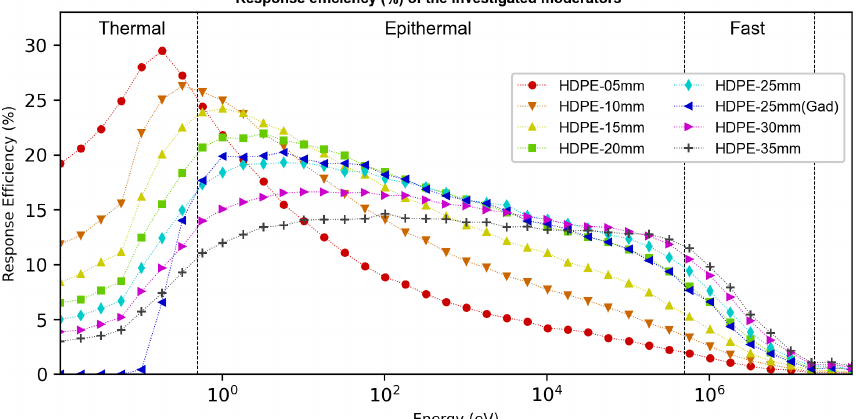
Figure 2. Energy-dependent response functions of different moderators made of 5 to 35mm thick high-density polyethylene (HDPE) and, in the case of 25mm HDPE, an additional gadolinium-based thermal